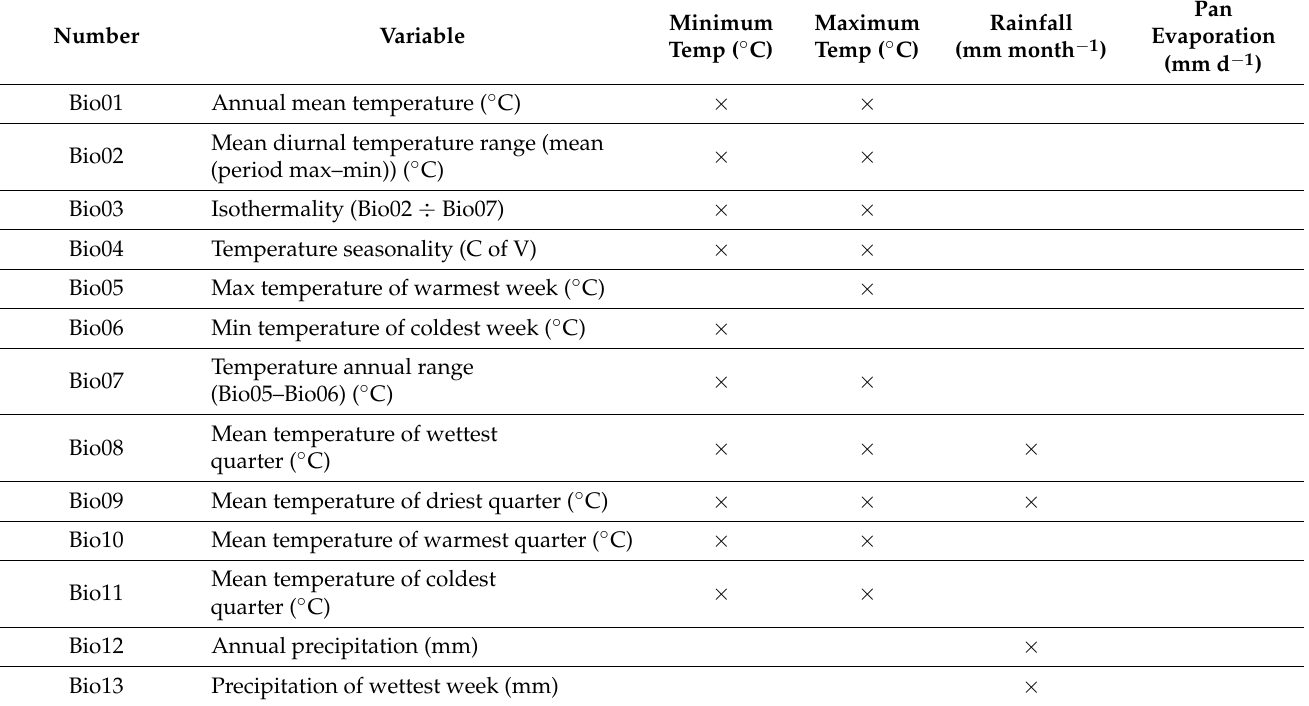
Table 2. Bioclimatic layers and the contributing variables used in their calculation (https://www. climond.org/, accessed on 5 January